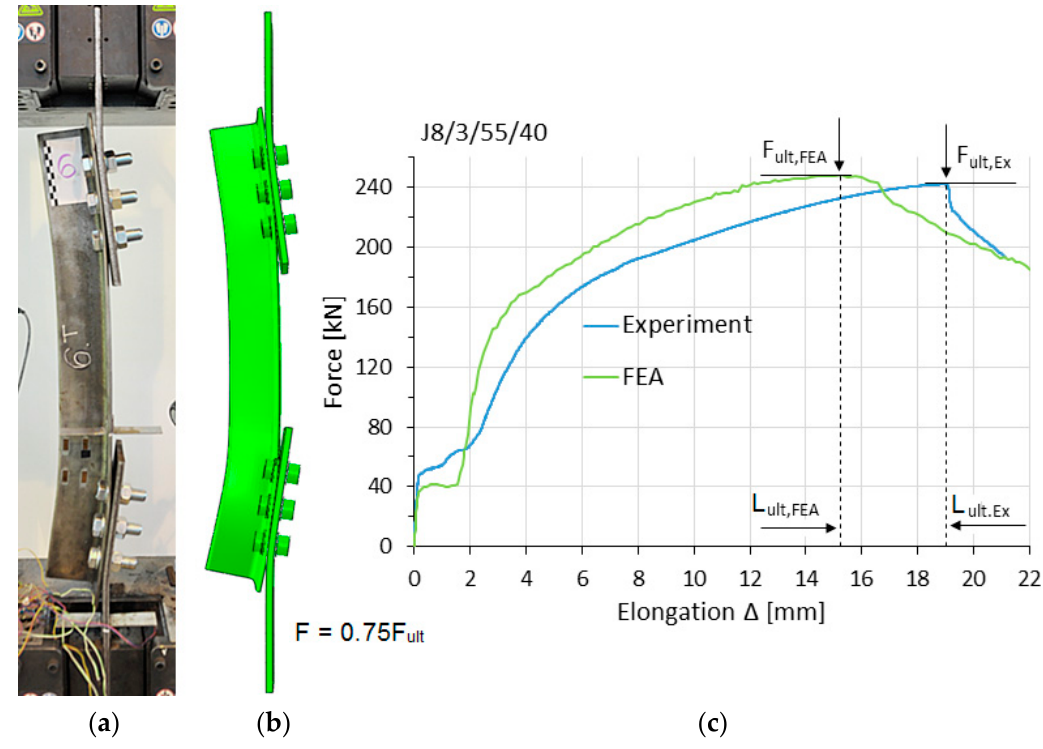
Figure 7. Specimen J8/3/55/40 in the failure phase: ( a ) experiment, ( b ) FE analysis (FEA) model, ( c ) F– ∆ curves.